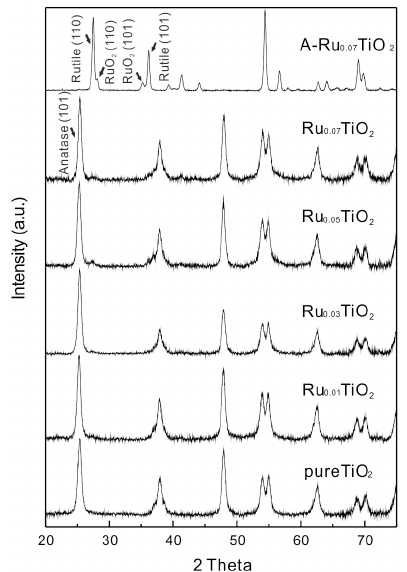
Figure 1. XRD patterns of synthesized Ru x TiO 2 .